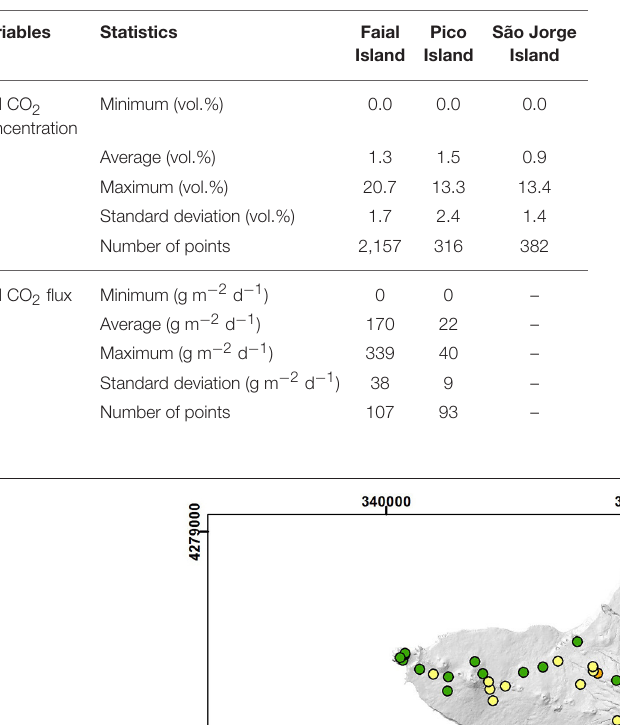
TABLE 2 | Descriptive statistics of the soil CO 2 concentration/flux data.